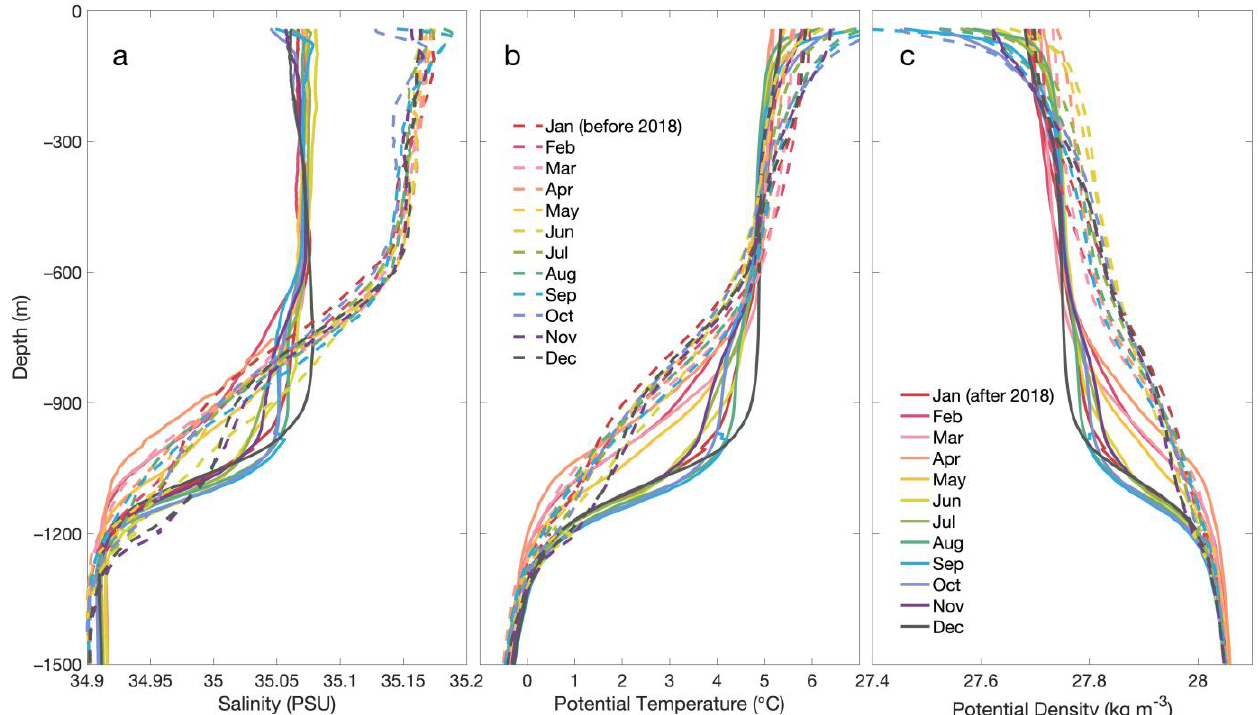
Figure 10. Climatological monthly ( a ) salinity, ( b ) potential temperature, and ( c ) potential density profiles in the inner circle of the CLV within a radius of 60 km. The dashed profiles are the mean profiles throughout the period of 2002–2017, and the solid lines are the mean profiles since 2018.